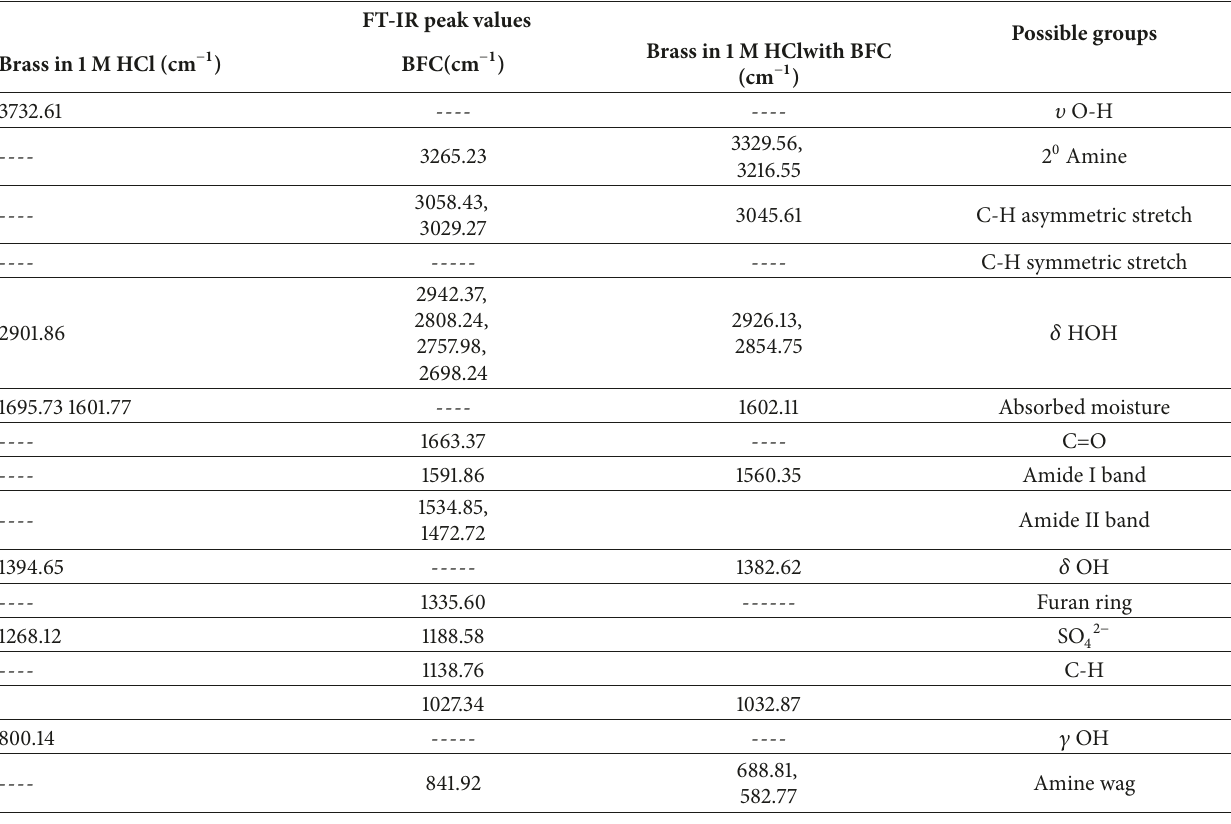
Table 7: FT-IR analysis of brass in 1 M HCl, BFC, and brass in 1 M HCl with BFC.